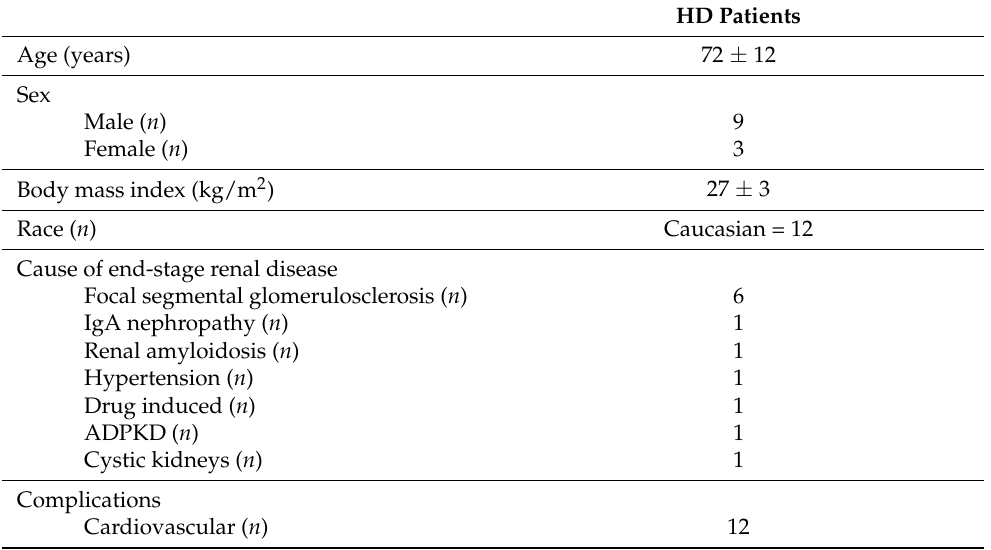
Table 1. Clinical features of hemodialysis (HD) patients ( n =